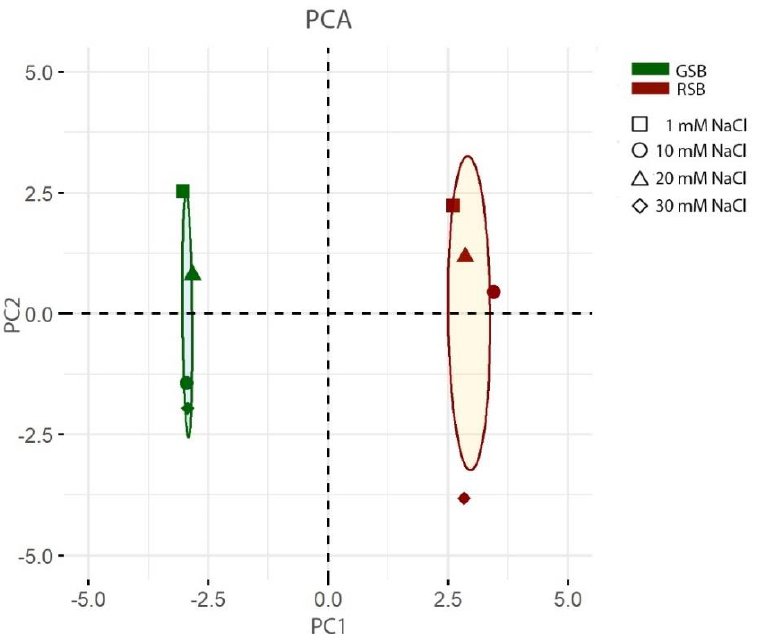
Figure 1. Principal component analysis (PCA) of the lettuce response to salt stress. The variance explained by the PC1 and PC2 is 62.0 and 30.5, respectively. The plot displays, in a two-dimensional space, clusters of samples based on their response to saline conditions. Red colored symbols refer to the RSB variety, while green symbols to GSB. Shapes indicate different NaCl concentrations in the nutrient solution—square: 1 mM; circle: 10 mM; triangle: 20 mM; diamond: 30 mM. For each variety, the plot displays a confidence ellipse (confidence level: 0.95) around the mean point (not shown).